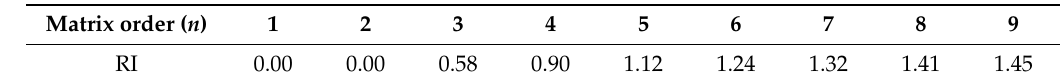
Table 2. Average random consistency index